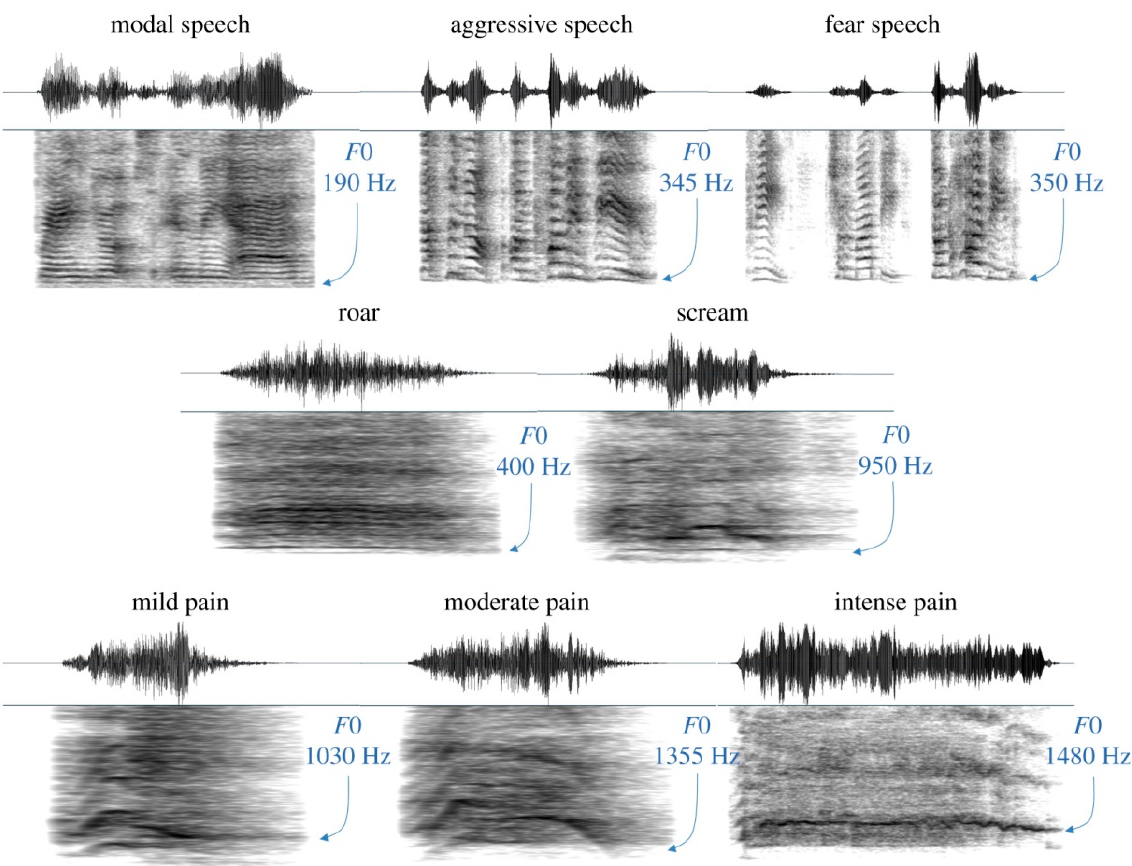
Figure 2. Waveforms and spectrograms representing each of eight vocal types produced by a single representative individual (female, aged 22), demonstrating the high degree of intra-individual variability in F0 across vocal types. Reprinted from Ref. [123].